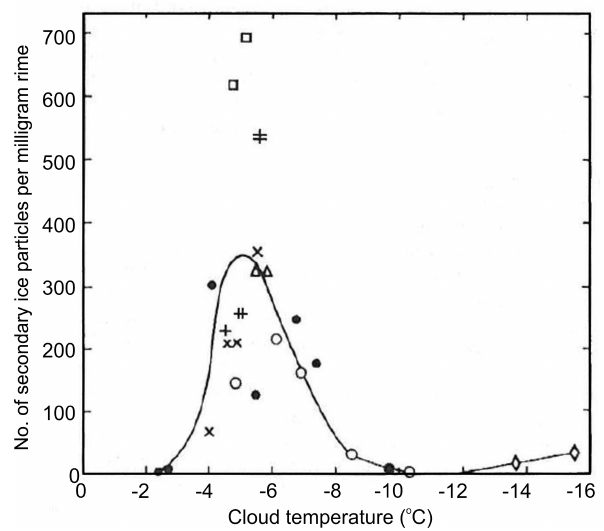
Figure 11. The dependence of the number of splinters per milligram of rime on ambient temperature at speed 2.7ms − 1 obtained exper- imentally by Hallett and Mossop